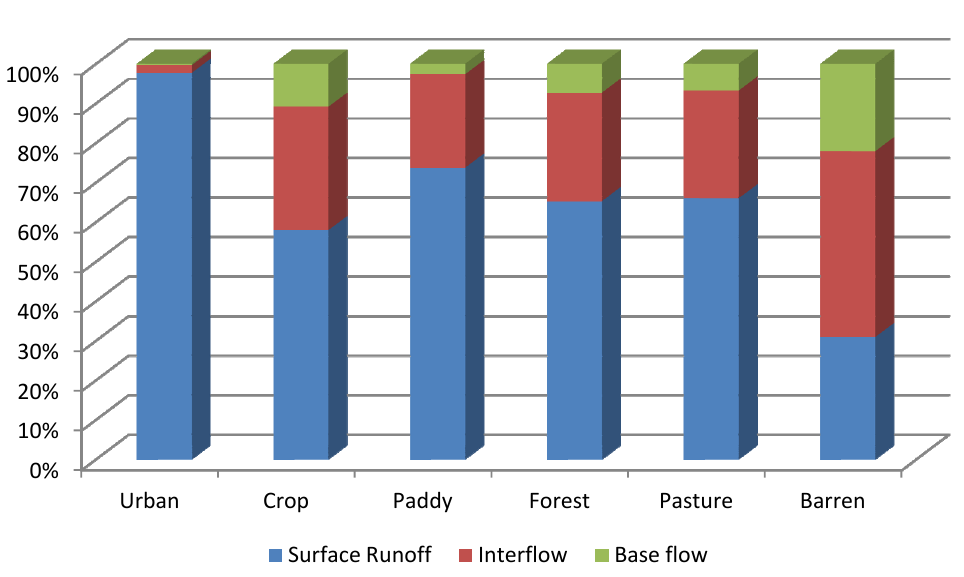
Figure 7. Comparison of rates of runoff components by land use type.